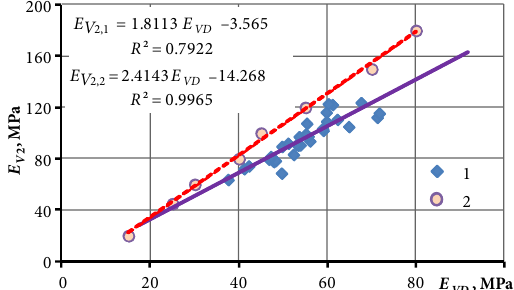
Fig. 2. Recommended approximate dynamic plate load test deformation modulus Evd convertion to static plate load test deformation modulus Ev 2 values (Lietuvos automobilių... 1995)